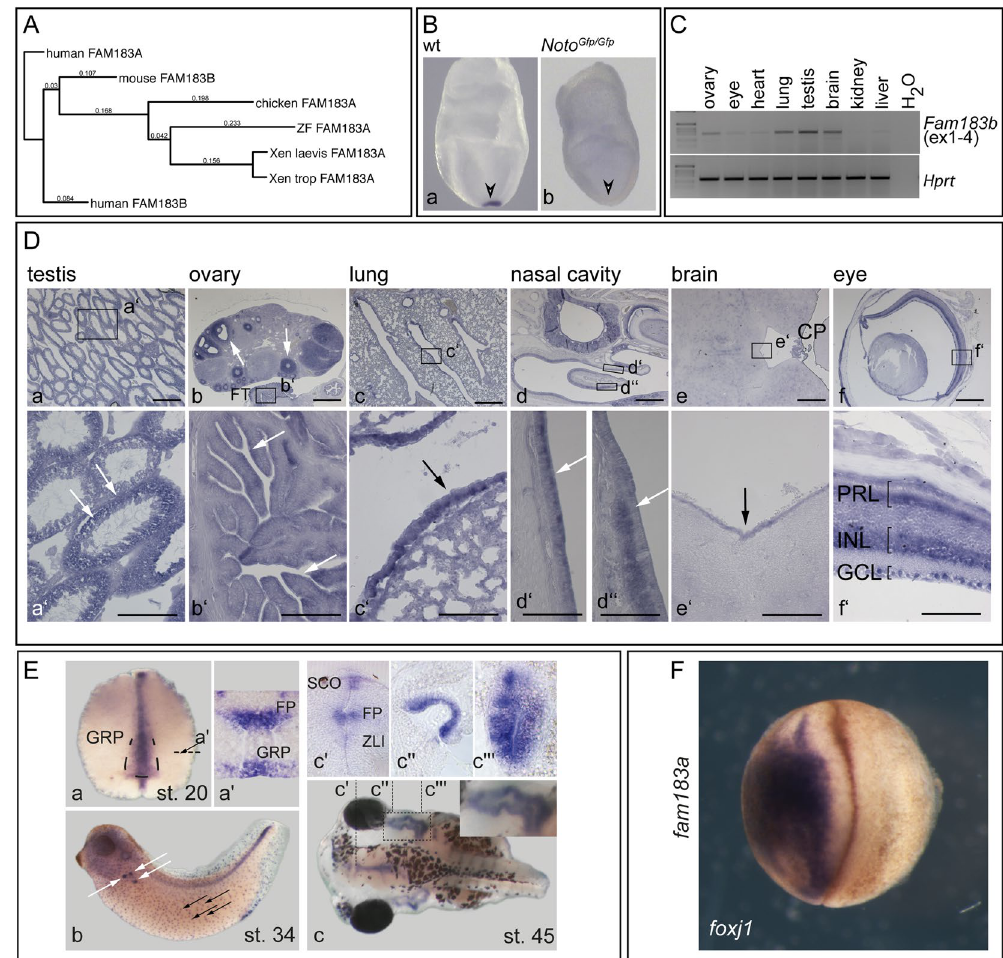
Figure 1. Expression of Fam183b . ( A ) Phylogram of vertebrate Fam183 genes rooted on human FAM183A . Sequences used for alignment and phylogenetic analysis: human, HGNC-34347 and HGNC-34511; mouse, Q5NC57; chicken, F1P3Y5; Xen. tropicalis, XP_004914015; Xen. laevis, XP_018113781; zebrafish, ZDB- GENE-111103-1. ( B ) WISH of E7.75 wild type (wt) (a) and Noto Gfp/Gfp (b) mutant embryos shows NOTO- dependent expression of Fam183b in the LRO. ( C ) Analysis of Fam183b expression by RT-PCR of RNA from adult organs, as indicated. Full size gel is shown in Supplementary Figure S1. ( D ) SISH analysis of adult tissues, as indicated. Boxed areas in a–f outline regions shown at higher magnification in a’–f’. Arrows point to sites of expression. FT: fallopian tube; CP: choroid plexus; PRL: photoreceptor layer; INL: inner nuclear layer; GCL: ganglion cell layer. ( E ) Expression of fam183a in Xenopus laevis . Fam183a mRNA was found at stage 20 in the floor plate (FP) and LRO (GRP; a,a’); at stage 34 in MCCs and nephrostomes (b); and at stage 45 (c) in the sub-commissural organ (SCO), the zona limitans intrathalamica (ZLI) and the floor plate of the brain (c’), in the dorsal lining of the branchial chamber (inset in c and c”), and the stomach (c”’). ( F ) Fam183a is a foxj1 target gene. Embryos were unilaterally injected on the left side with a foxj1 mRNA and analysed for fam183a expression. foxj1 , injected side. Scale bars: Da–f = 500 μ m, a’–f’ = 100 μ